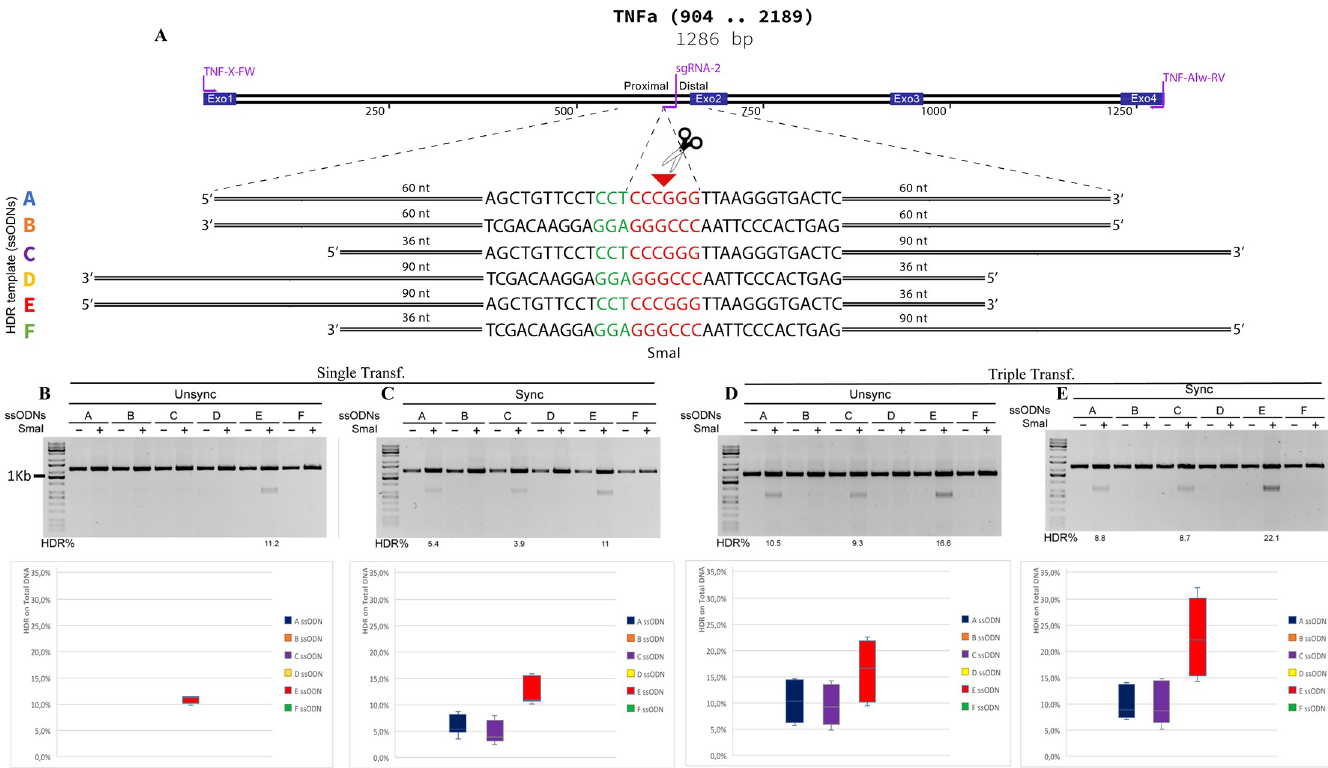
Fig 3. Systematic investigation of DNA templates for efficient HDR at the TNF α locus in HEK293 cells. (A) A segment of human TNF α shows the genome structure, the sgRNA2 guide site, and the primer used for PCR amplification (in violet). +1: ATG. Six HDR templates (color-coded) were tested for HDR efficiency, the PAM region (in green). Template ssODN contains SmaI restriction sites (in red) flanked by various lengths of homology arms. (B) HDR efficiency was tested in single and triple transfection, in combination with synchronized cells. The mean % HDR and standard deviation (error bar) were determined by bands quantification after SmaI digestion from seven and eight replicates. Representative gels from PCR and HDR analyses are shown for each cell condition. Not determined, ND.